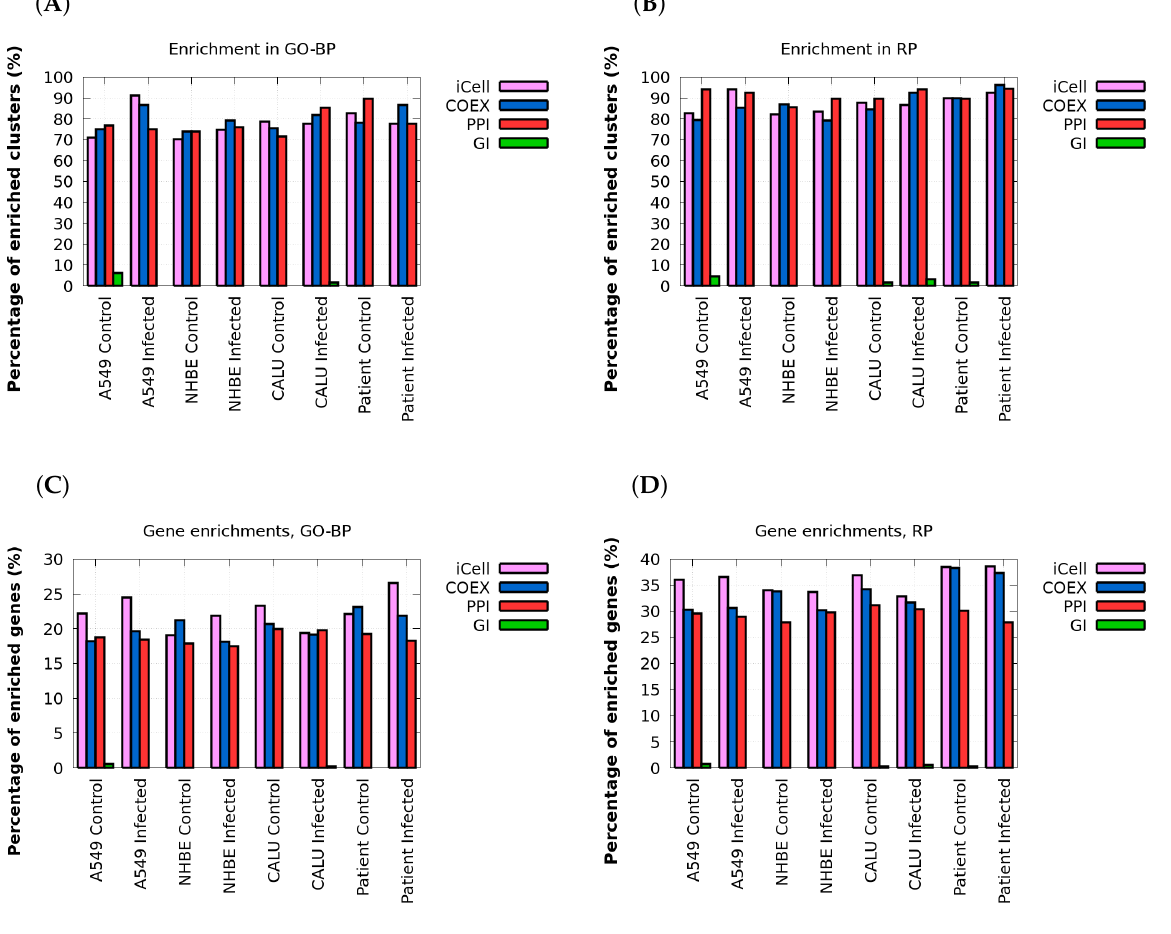
Figure 2. Clusters in iCells have more enriched genes. In panel ( A ), for each tissue and for each network type (x axis) the bar plot shows the percentages of the clusters that have at least one Gene Ontology Biological Process (GO-BP) annotation enriched. Panel ( B ) shows the same, but for Reactome Pathway (RP) annotations. In panel ( C ), for each tissue and for each network type (x-axis), the bar plot shows the percentages of annotated genes in the clusters that have at least one GO-BP annotation enriched in their clusters. Panel ( D ) shows the same, but for RP